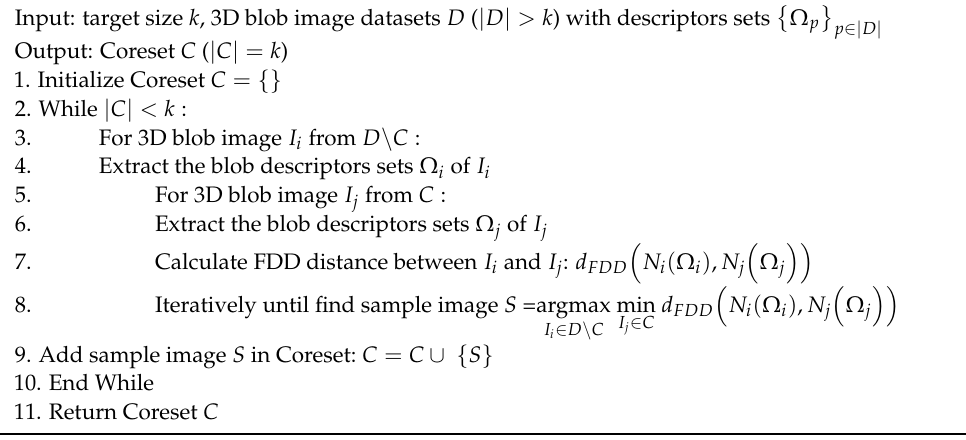
Algorithm 1: Pseudocode for FDD ‐ Coreset.